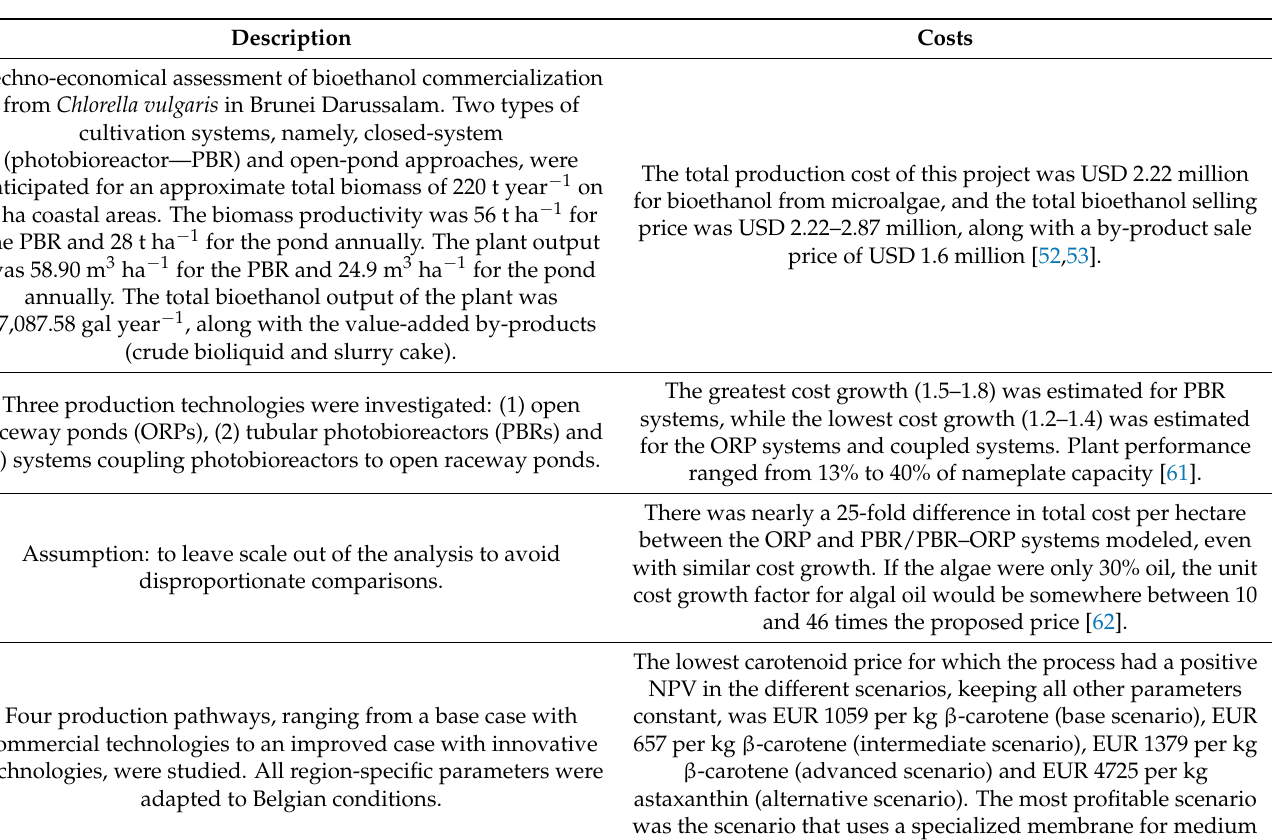
Table 5. Examples of techno-economical assessments of technologies using